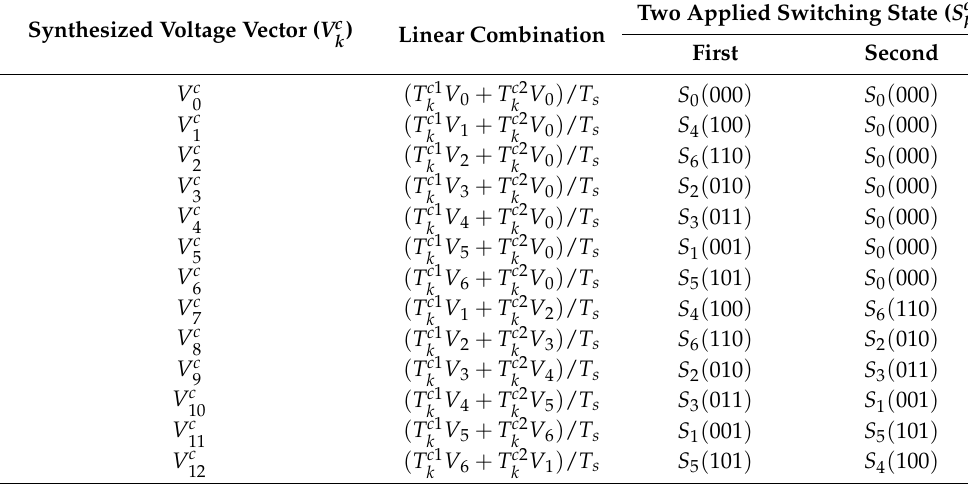
Table 2. Synthesized voltage vectors and switching